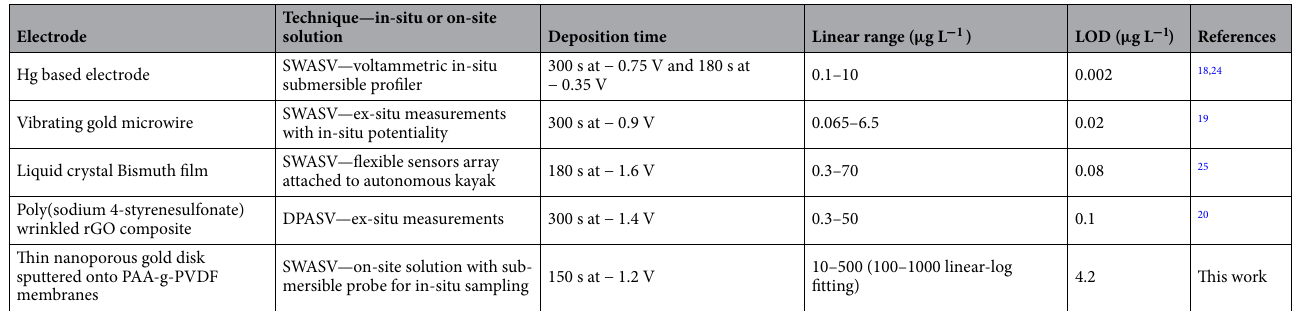
Table 1. Comparison of Zn(II) electrochemical sensors demonstrating true or high potential application for real seawater analyses with reported sensor—for data conversion molar concentrations were multiplied by M Zn = 65.39 g mol − 1